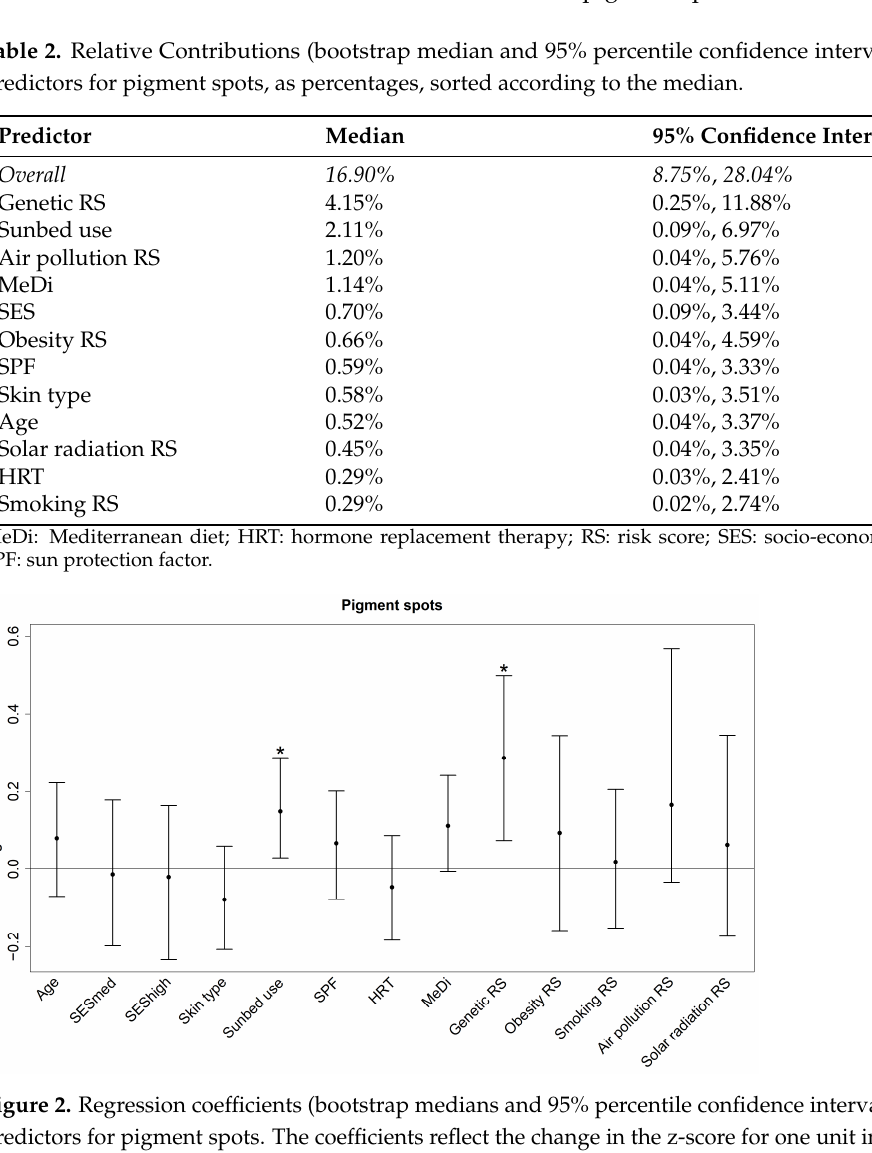
Table 3. Relative Contributions (bootstrap median and 95% percentile confidence interval) of the predictors for FEV 1 , as percentages, sorted according to the median. Predictor